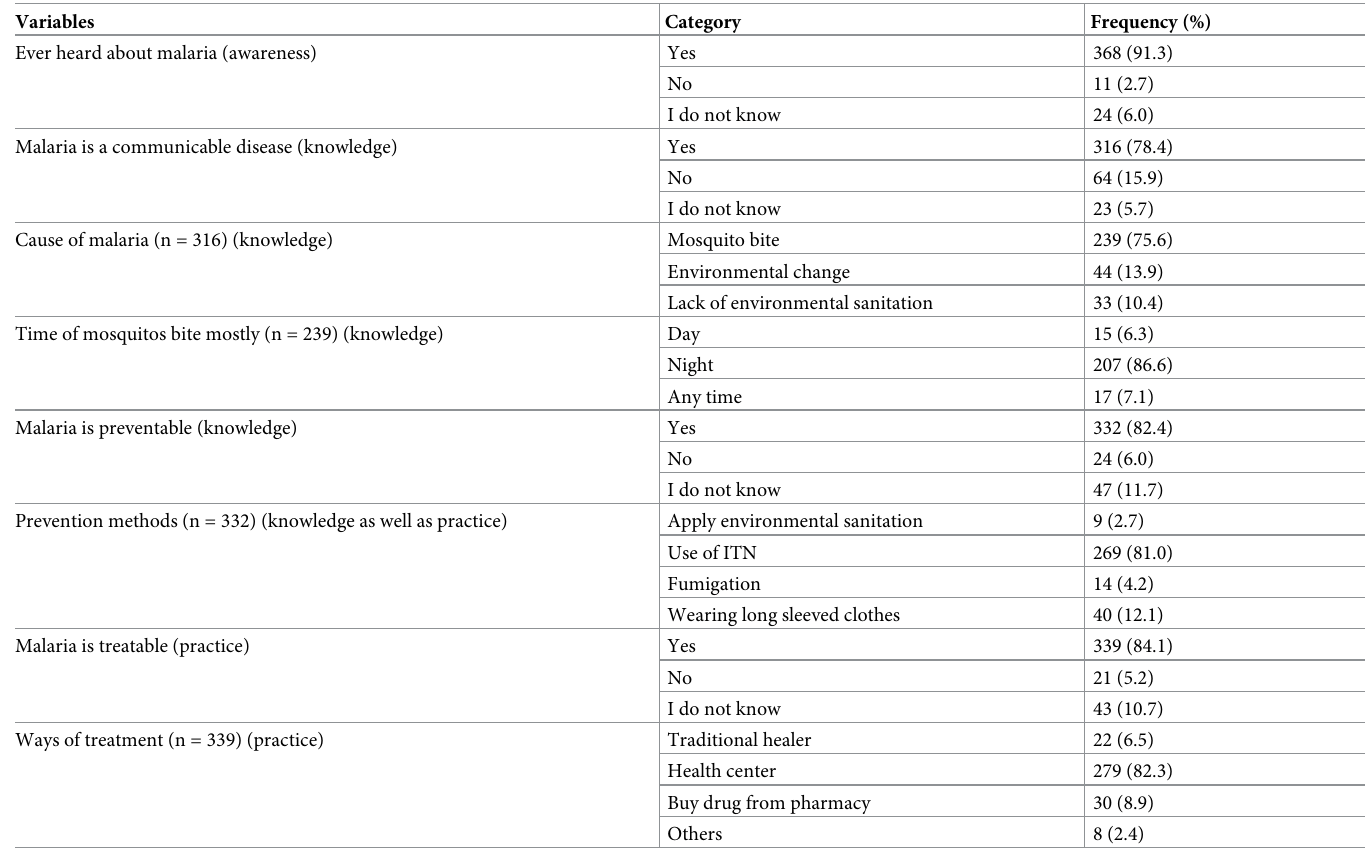
Table 3. Awareness about cause, transmission, prevention and control of malaria ( N =